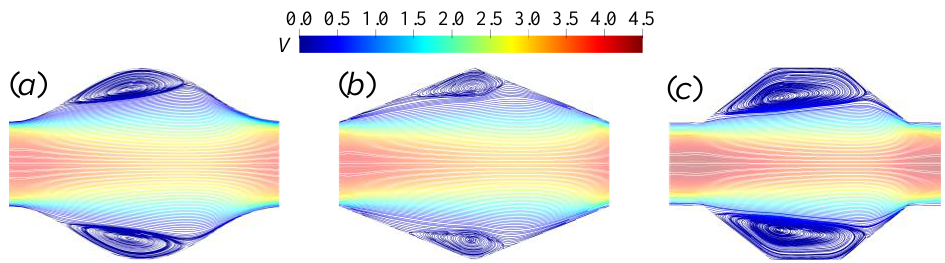
Figure 7. Streamlines in the last corrugation wave with ( a ) sinusoidal, ( b ) triangular and ( c ) trape- zoidal profiles when Re gen,CY = 130.